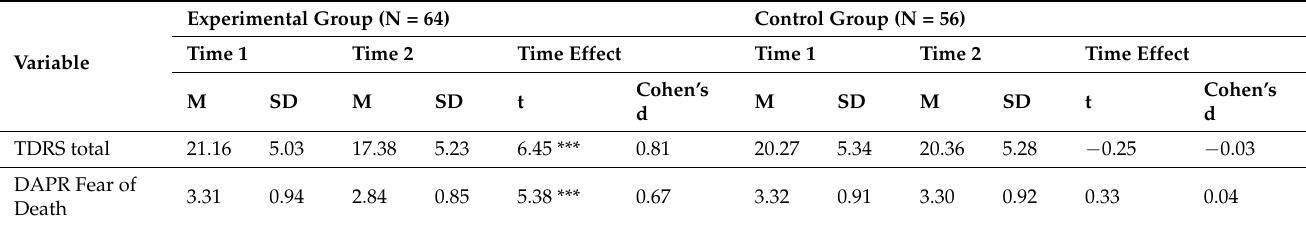
Table 2. Change over time examination in the experimental and control